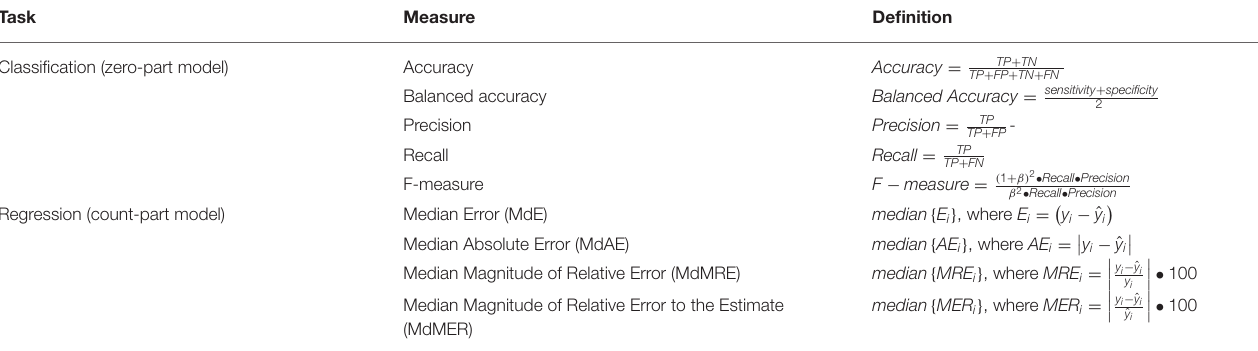
TABLE 2 | Performance evaluation metrics for classification and regression tasks.